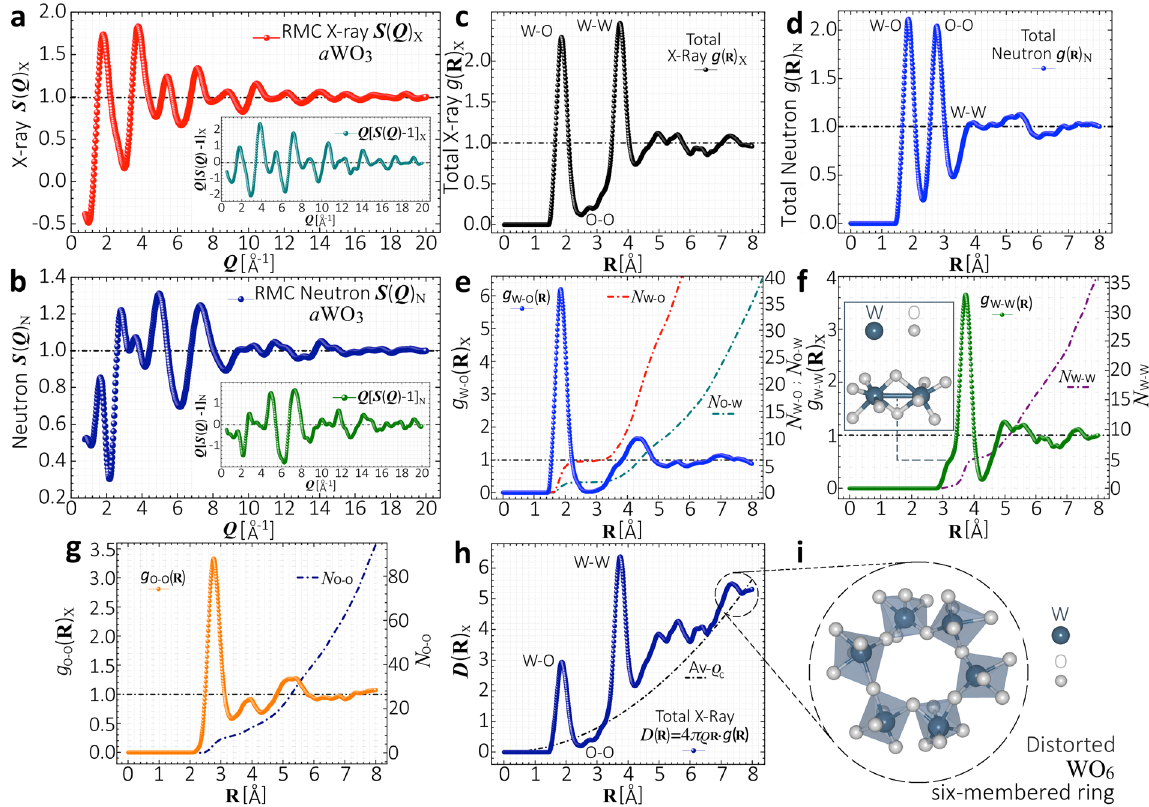
Figure 3. Structure pair correlation functions. ( a ) Calculated X-ray S Q ( ) and ( b ) Neutron S Q ( ) structure X N factors from RMC-EXAFS simulated structures of a WO 3 . Insets display the reduced structure function Q [ S Q ( ) − 1]. ( c ) Calculated total X-ray g R ( ) , and ( d ) Neutron g R ( ) pair distribution functions. ( e – g ) X-ray partial X N distribution functions g W-O ( R ), g W-W ( R ), g O-O ( R ) and corresponding atomic coordination N W-O , N O-W , N W-W , N O- ≈ 3.1 Å, in neighboring edge-sharing WO O . Inset in ( f ) shows a W-W pair with bond-length R x structural units. ( h ) Total X-ray D ( R ) = 4 πρ R · g ( R ), the dotted line corresponds to the average density contribution [Av- ρ c ]. ( i ) Formation of WO 6 six-membered rings associated to the peak at R ≈ 7.3 Å in the D ( R ) of ( h ), and in g R ( ) , X g R ( ) N of ( c – g